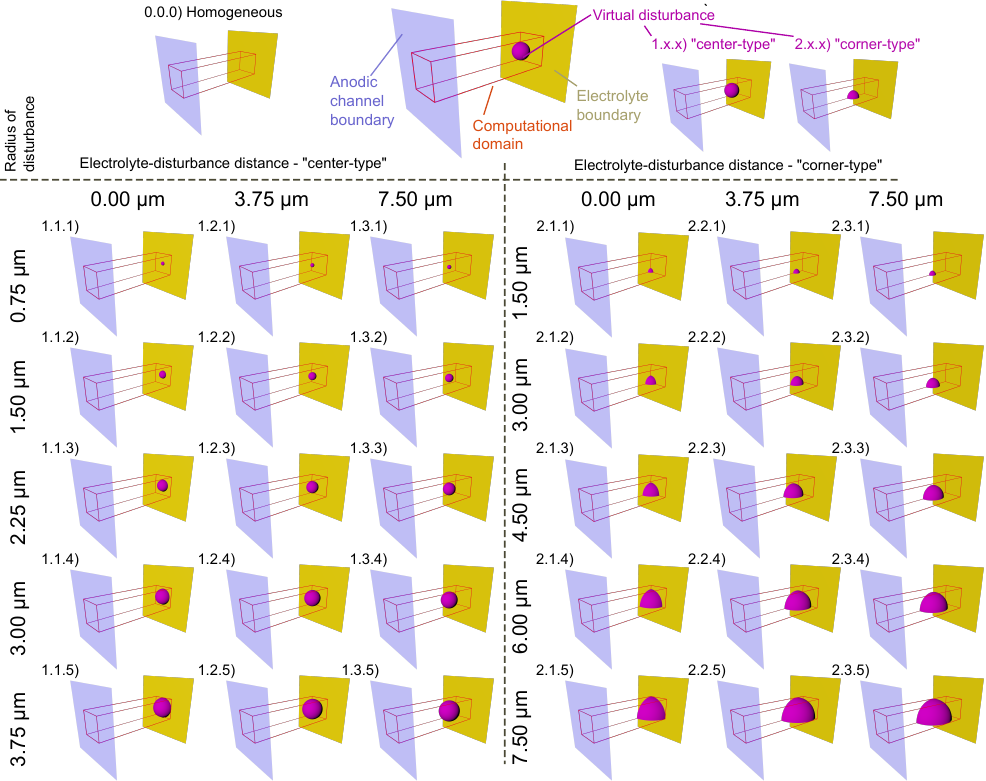
Figure 2. Parametric study cases: type, size and placement of the virtual disturbance within the